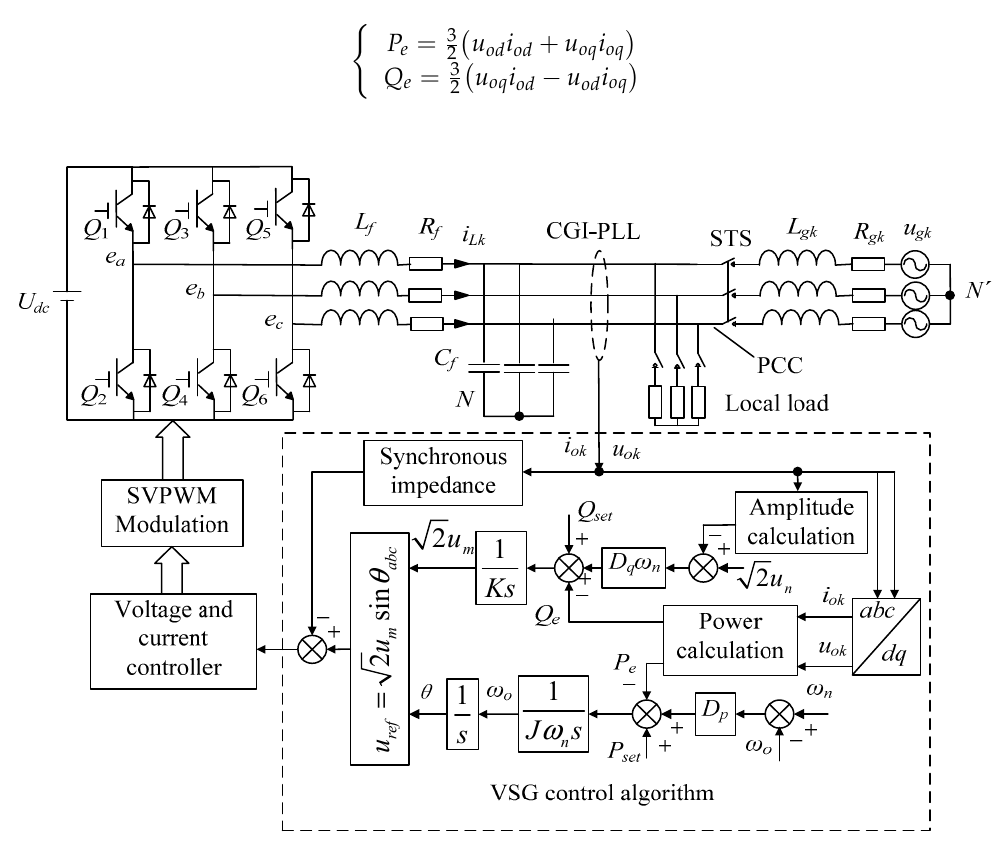
Figure 1. Control block diagram of voltage source inverter.